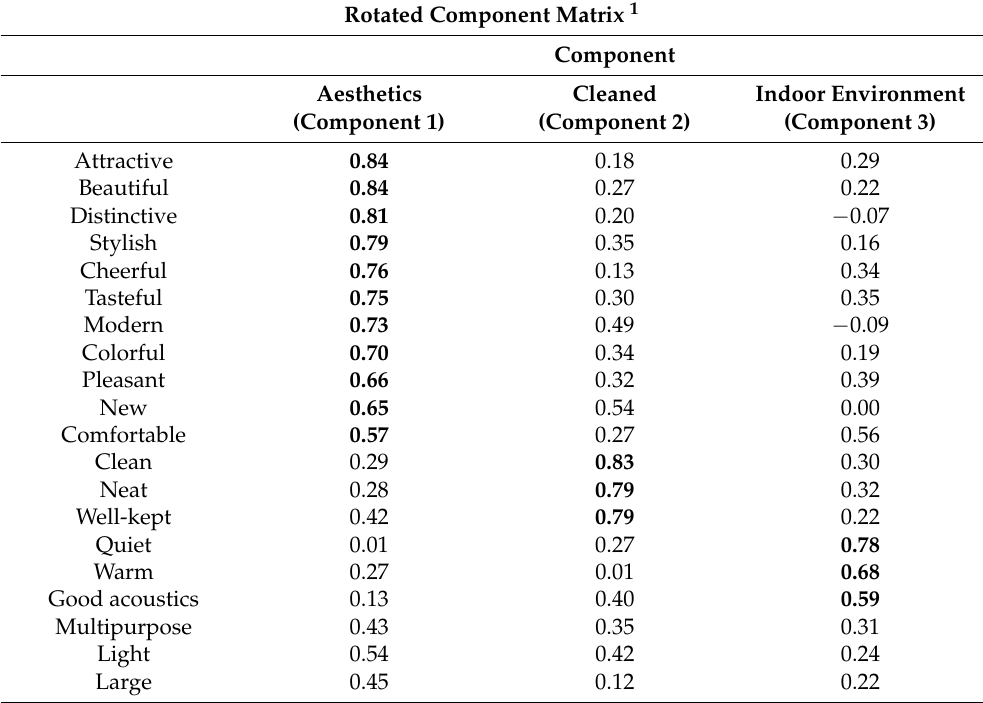
Table 14. Locations, rotated component matrix with three components with their labels and factor loadings on the variables. Factor loading >0.55 are in bold—“How would you describe this location?”. Rotated Component Matrix 1